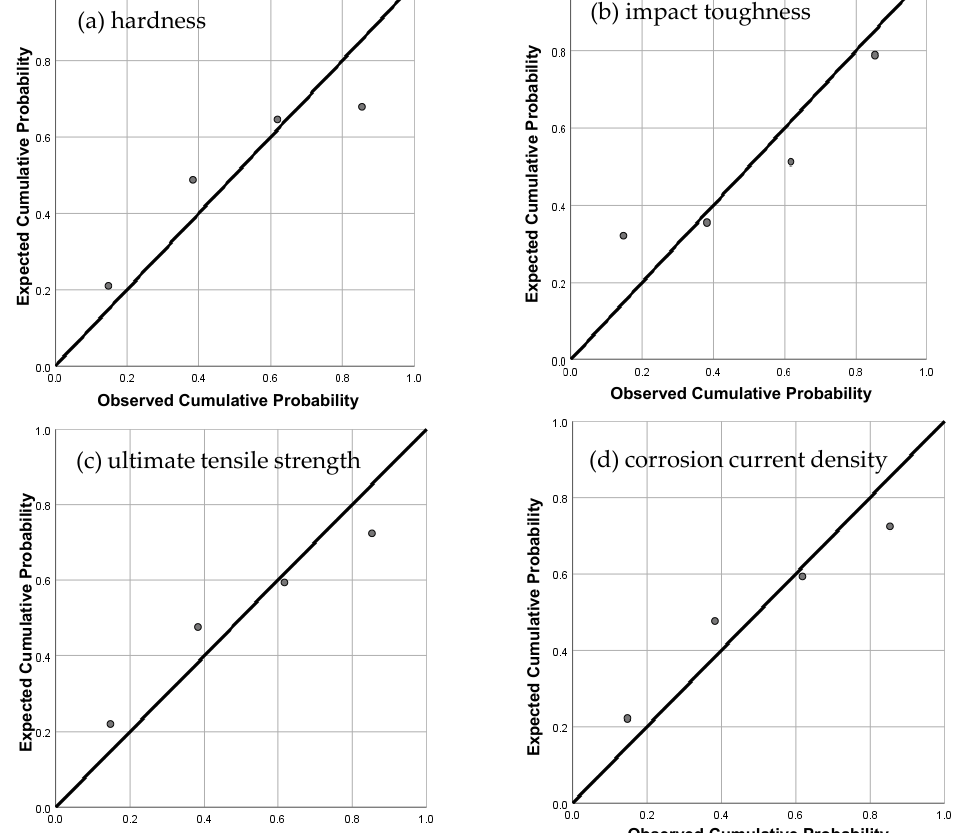
Figure 2. Normal probability plot of properties of duplex stainless steel: ( a ) hardness; ( b ) impact toughness; ( c ) ultimate tensile strength; ( d ) corrosion current density.